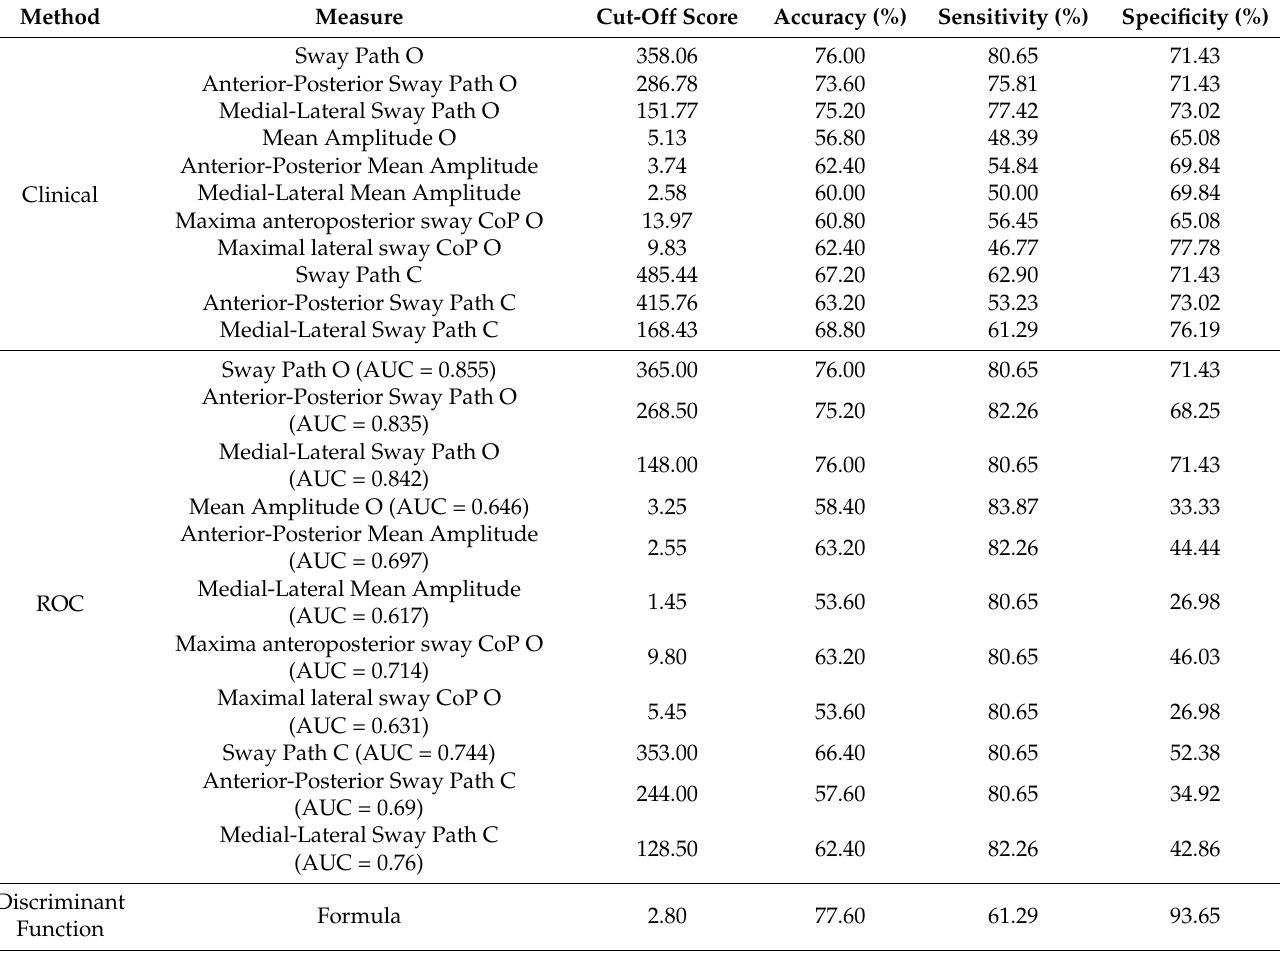
Table 5. Clinical, ROC, and discriminant function cut-off scores for a high risk for falling